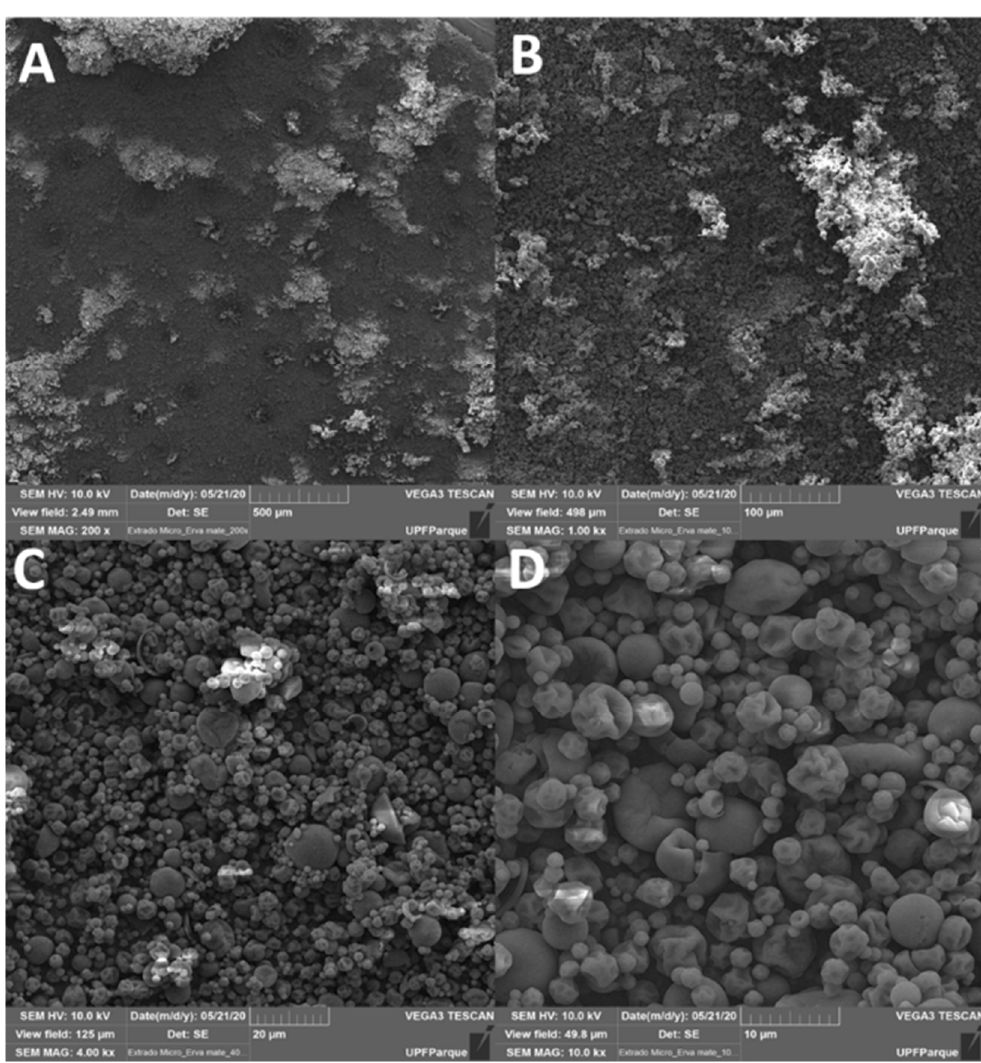
Figure 1. Scanning electron microscope (Phenom XL, Thermo scientific) in MEIP. ( A ) 200×; ( B ) 1000×; ( C ) 4000×; ( D ) 10000× of magnification.